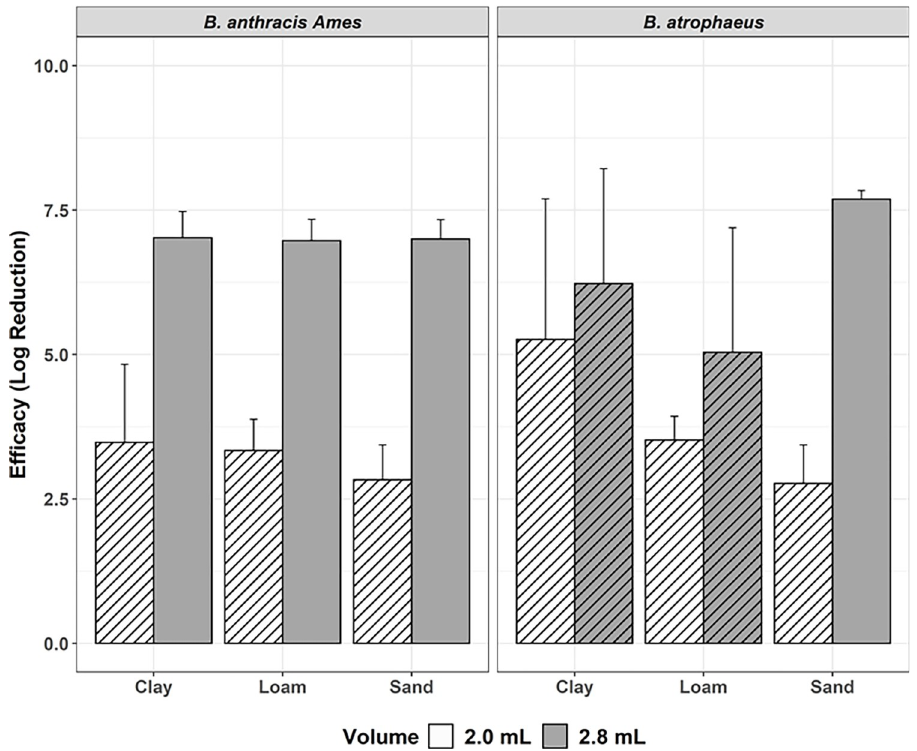
Fig 2. Efficacy of 2.0 mL (white; Test 3) vs. 2.8 mL (gray; Test 2) 2.5% formaldehyde. Tests conducted at ambient temperature, uncovered, against B . a . and B . atrophaeus , with efficacy represented by log reduction ( ± 95% CI) of bacteria, by soil type, and 48-hour contact time. Columns with stripes are samples that did not achieve complete